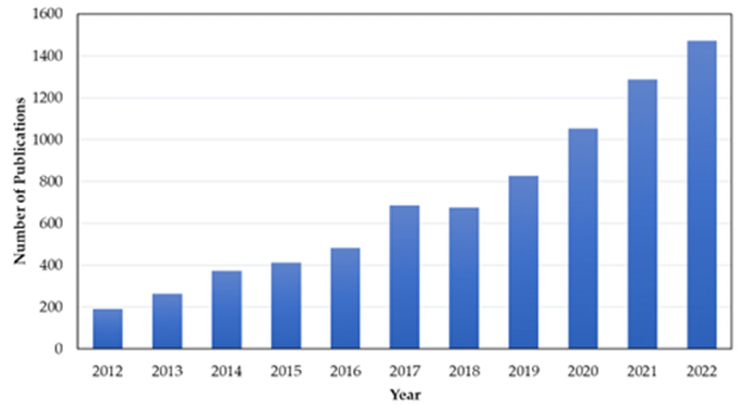
Figure 1. Published papers from past 10 years using key words “PCM, Cold Storage, PCM